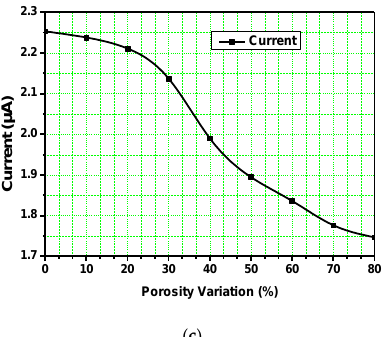
Figure 7. Porosity variations effect on voltage and current: ( a ) piezoelectric bimorphs and cylinders, ( b ) total cumulative voltage vs first-eigen frequency at various porosity and, ( c ) current intensities at various porosities.